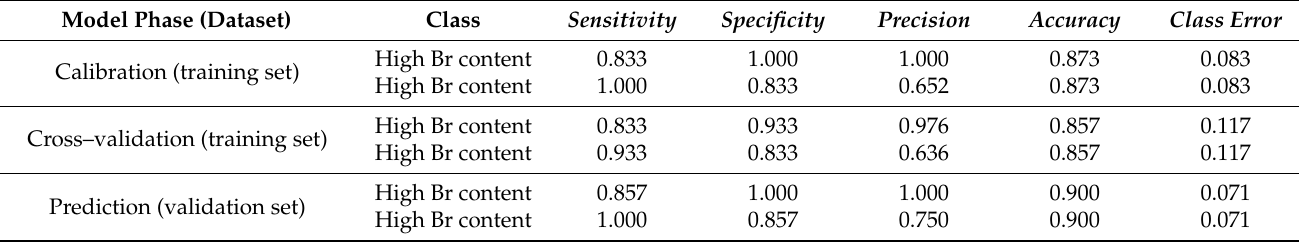
Table 4. Classification performance metrics for bromine content using ASD FieldSpec ® 4 Standard-Res data. Model Phase (Dataset)